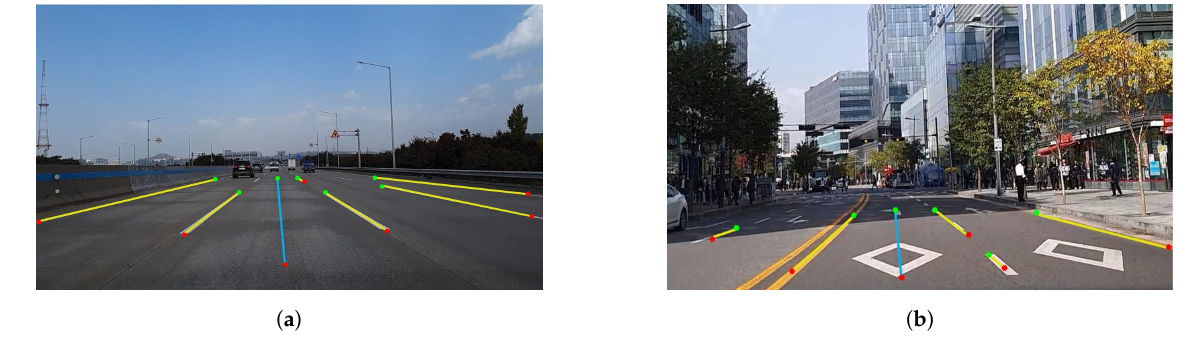
Figure 6. Example of extraction of driving link information: ( a ) highway area; ( b ) urban